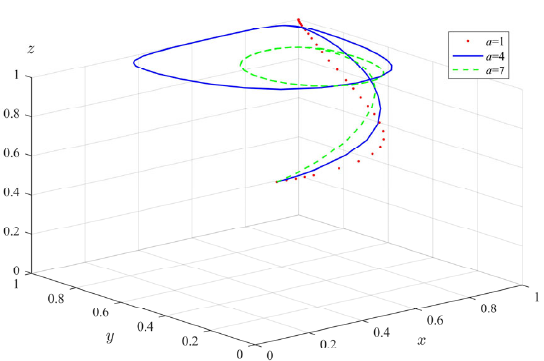
Figure 10. The impact of fixed subsidies ( a ) on the evolution of tripartite behavior.